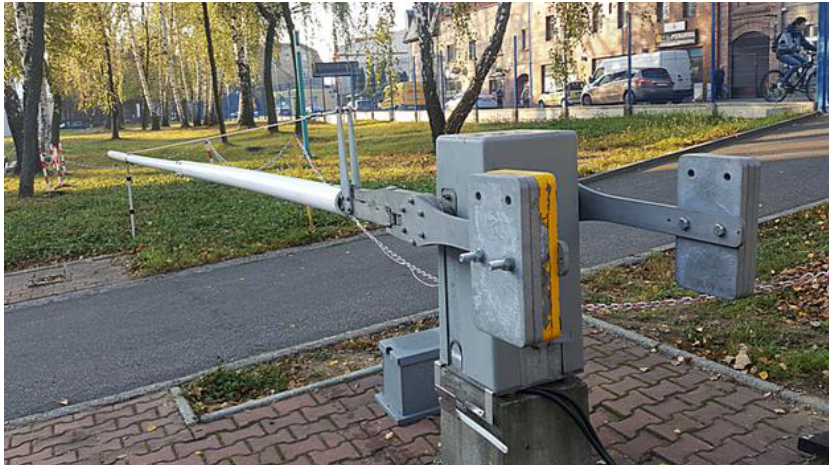
Figure 1. Barrier machine of an automatic level crossing system.